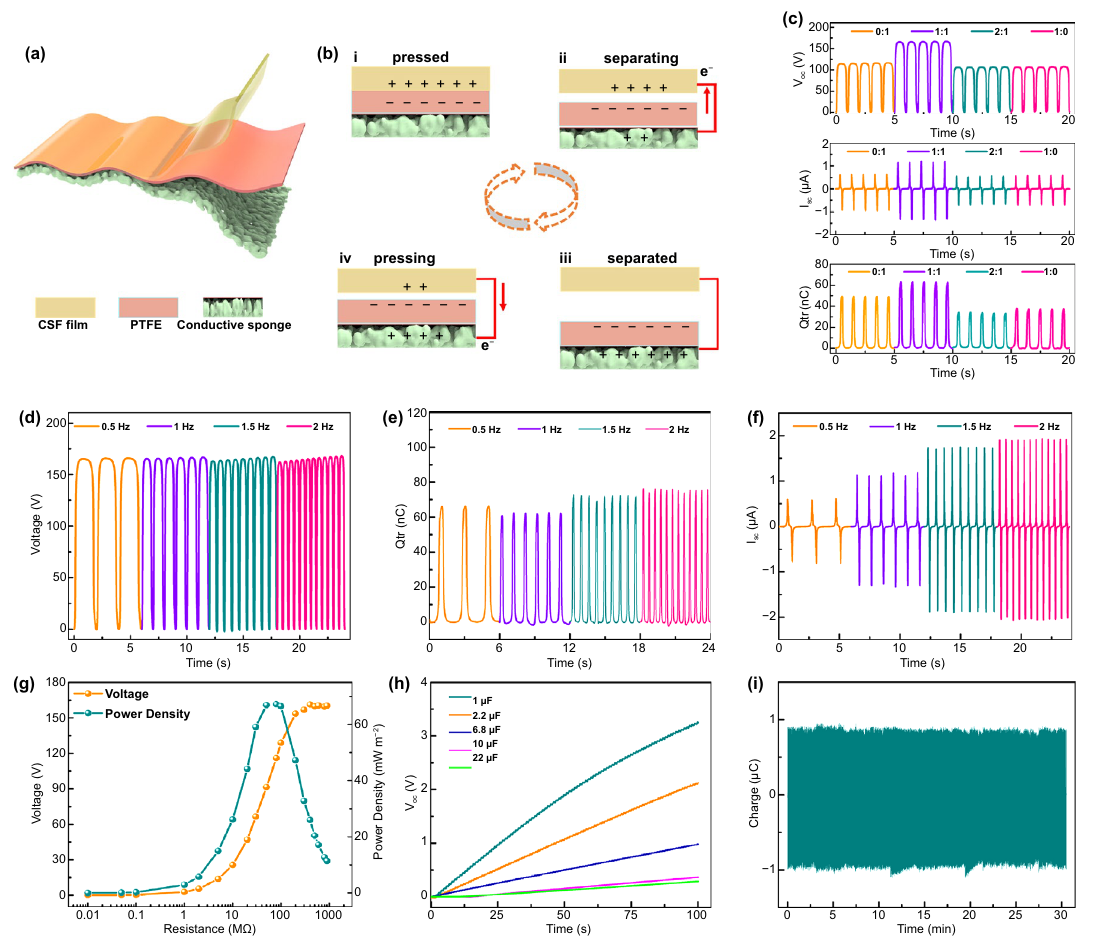
Fig. 3 Operating principles and output performance of the CSF-TENG. a A schematic structure of the CSF-TENG. b A schematic working principle of the contact-separation mode CSF-TENG for energy harvesting. Electrical output performance of CSF-TENG. c V oc , Q sc , and I sc of CSF-TENG for different introduction concentrations of SF. d–f Frequency–response characteristics of CSF-TENG under different loading frequencies (0.5–2 Hz), including d V oc , e Q sc , and f I sc . g The variation of voltage and peak power density under varied external resistances. h Charging performance under different capacitors (1–22 µF). i Stability test of CSF-TENG under continuous impact for 30